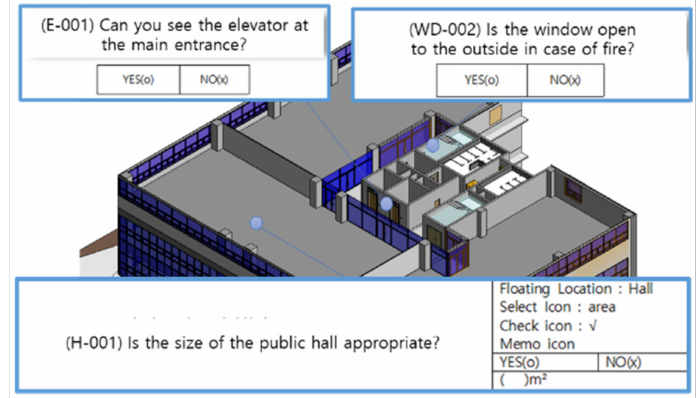
Figure 6. Example of design checklist connection.